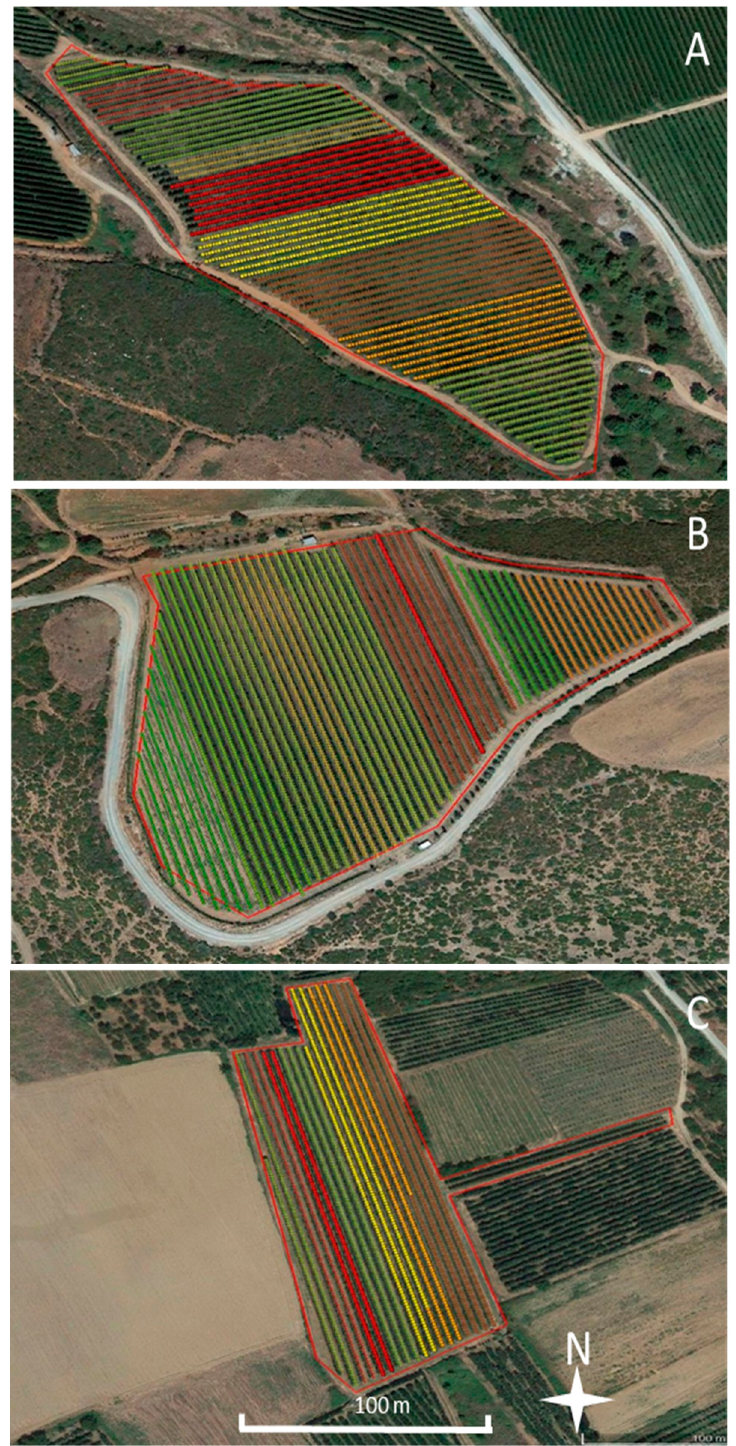
Figure 4. Digitization of different cherry cultivars (location and ripening period) in commercial cherry orchards used in our study. Different colors indicate different cherry cultivars. ( A ) Orchard #1, ( B ) Orchard #2, and ( C ) Orchard #3.